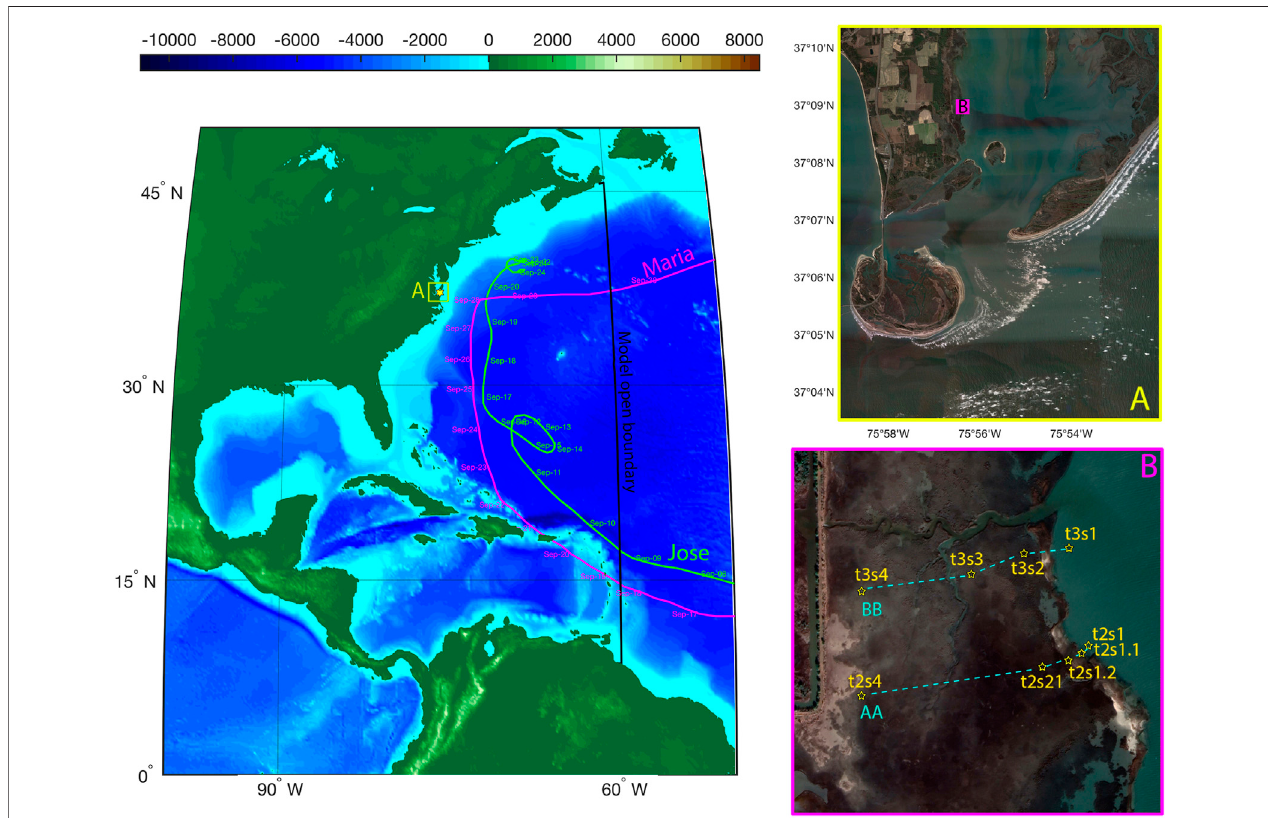
FIGURE5| NumericaldomainextentfortheeastcoastoftheUnitedStates.Theblacklineshowstheopenboundaries.Thebesttrackswithtimetagsofhurricanes Maria and Jose (2017) areshown bymagentaand green lines,respectively. Thezoom-in windows in Magothy Bay and thelocations ofwaveand water level gauges are shown in the left-hand side panels.